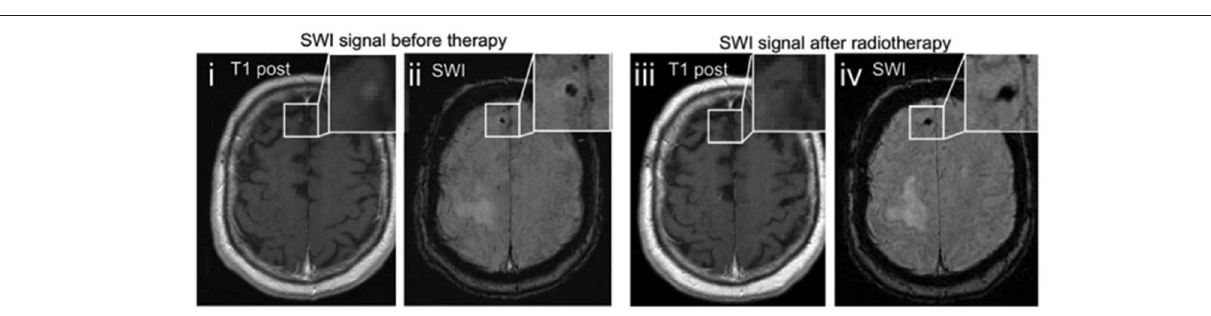
FIGURE 3 | Therapy related changes of SWI. Example images of a melanoma metastasis before (i, ii) and after radiotherapy (iii, iv). The punctuate contrast enhancement in the right frontal lobe (i) disappears after stereotactic radiotherapy (iii), being consistent with radiological remission. The SWI signal drop remains as a remnant of the preexisting metastasis (iv). Adapted from Schwarz et al. (